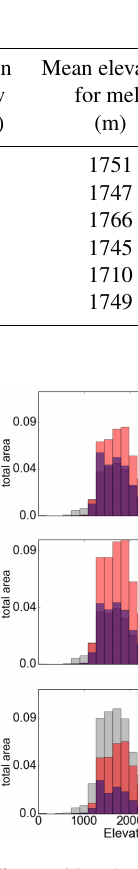
Figure 11. Histograms of the relationship between elevation and the dominant mechanisms for snow ephemerality in the Great Basin from water years